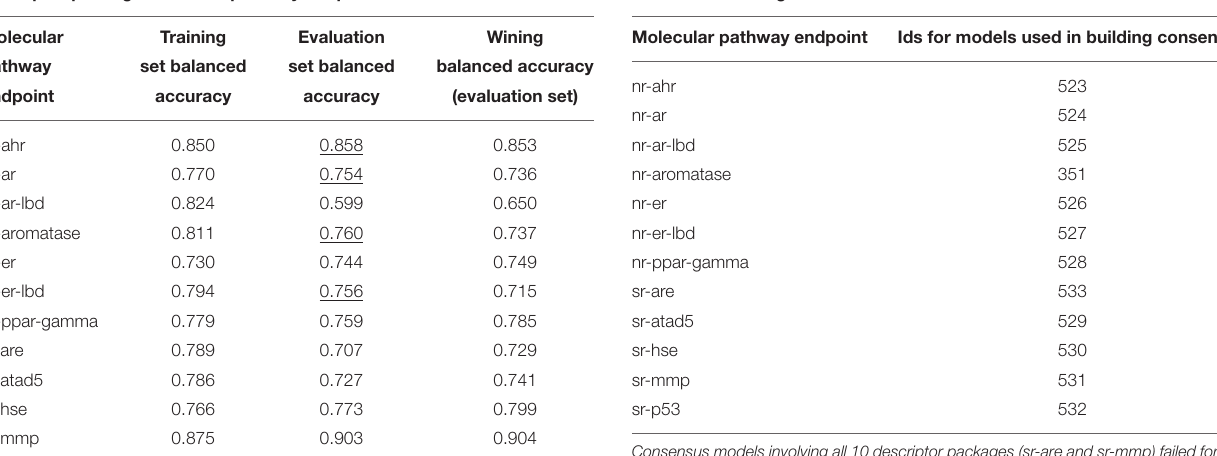
TABLE 6 | Models used for the final submission by team AMAZIZ during the Tox21